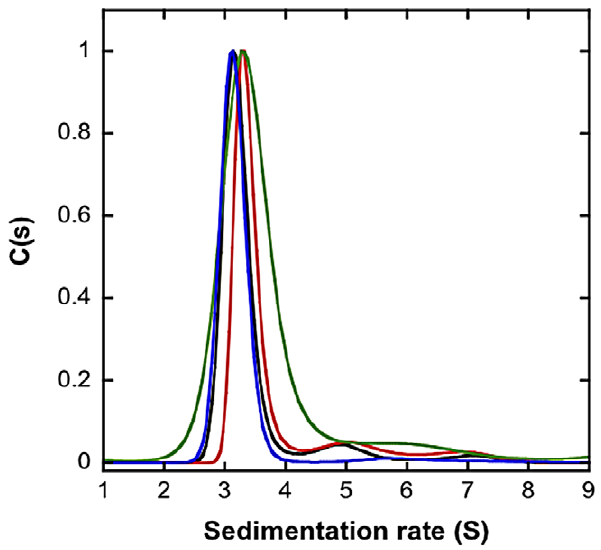
Figure 3. Mutation of Leu46 does not alter the quaternary structure of MIF. Sedimentation rate distributions as determined